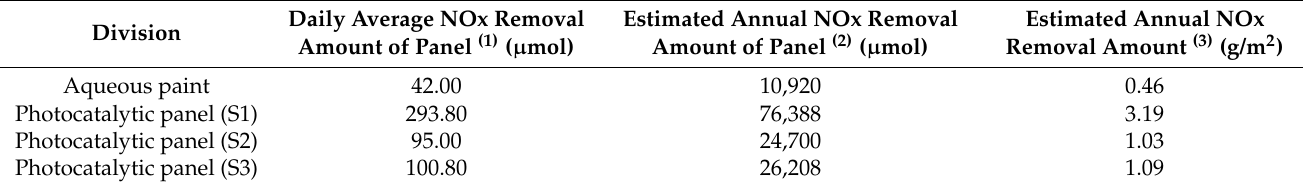
Table 11. Washing water field test results of photocatalytic